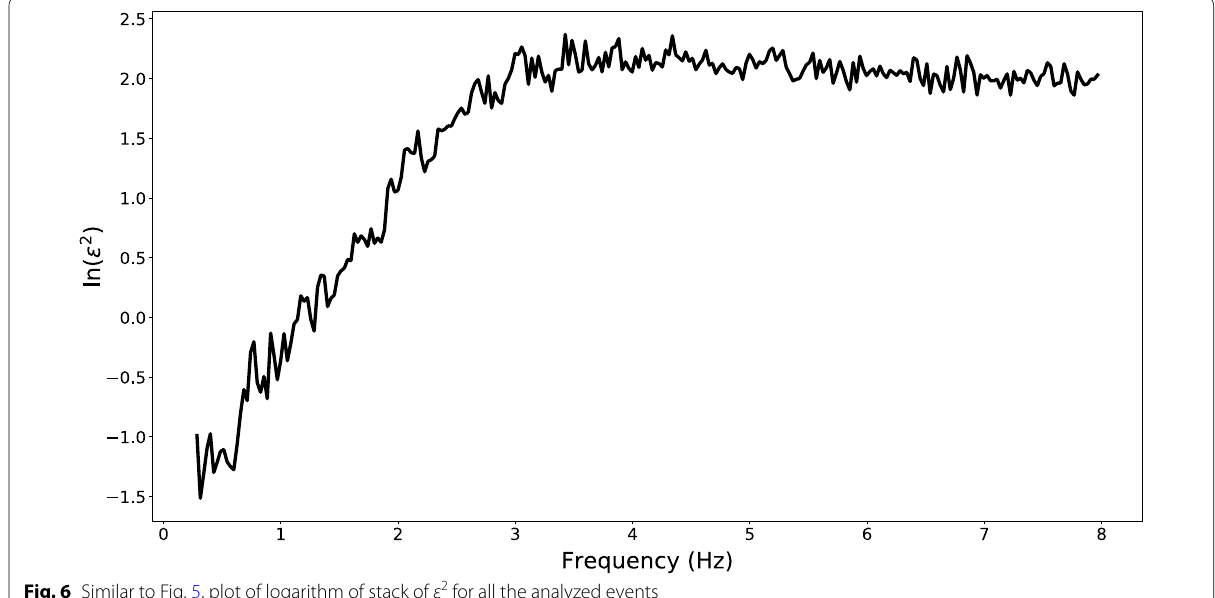
Fig. 6 Similar to Fig. 5, plot of logarithm of stack of ε 2 for all the analyzed